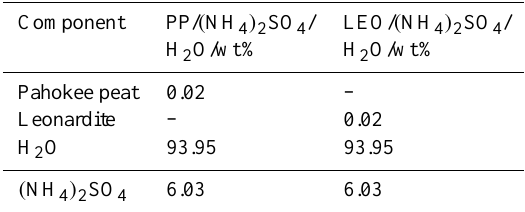
Table 1. Composition of Pahokee peat (PP) and leonardite (LEO) containing aqueous ammonium sulfate droplets employed in ice nu- cleation